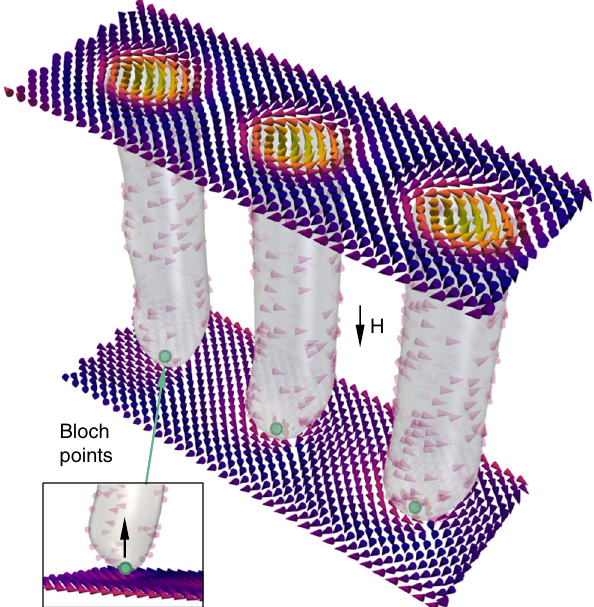
Fig. 1 Visualisation of the skyrmion tube spin texture. Three dimensional visualisation of three magnetic skyrmion tubes from the micromagnetic simulations presented in this paper, illustrating their extended spin structure. The inset highlights the location of the magnetic Bloch point at the end of each skyrmion